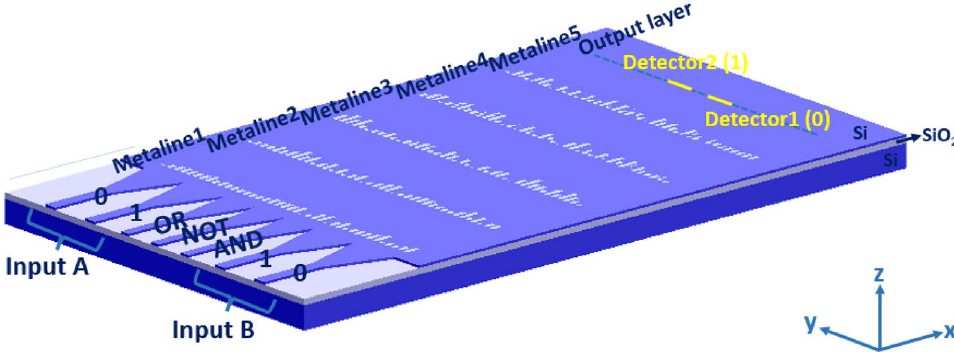
Figure 1. Schematic of on-chip diffractive optical neural network trained to perform optical logic operations AND, NOT and OR. Thera are seven input waveguide-tapers, three of which are for control signals AND, NOT and OR. Metalines (1D-metasurafces) are the diffractive neural network hidden layers. Meta-atoms on each metaline act as neurons. There are two detectors at the output layer corresponding to the computing results “0” and “1”. The propagation direction is along